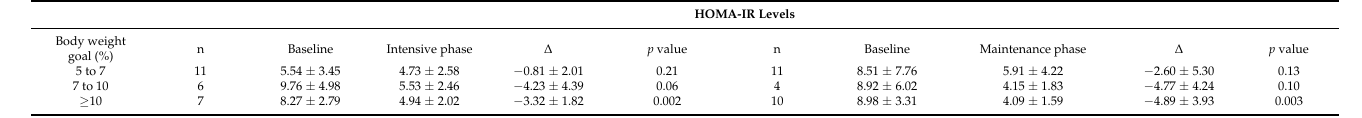
Table 2. Comparison of HOMA-IR levels by body weight loss